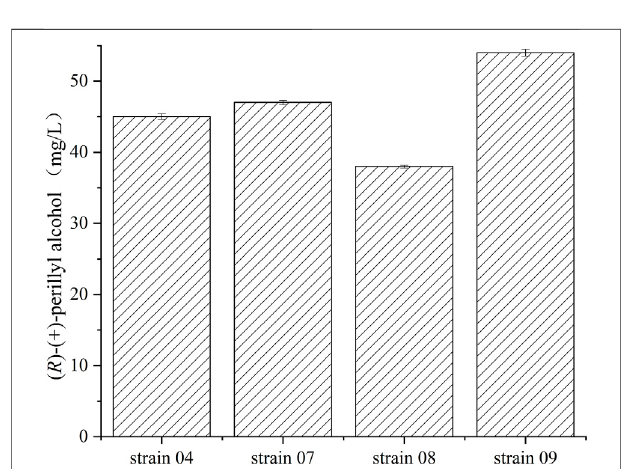
FIGURE 3 | Various concentrations of ( R )-(+)-perillyl alcohol production by different E. coli strains. Reaction conditions (20 ml): whole cell catalysts (OD 600 =30),25 μ l( R )-(+)-limonene,8.0 mldioctylphthalate(DINP),and PBS buffer (50 mM, pH 7.4) at 30 ° C for 6 h. Data expressed as mean ± s.d. ( n =